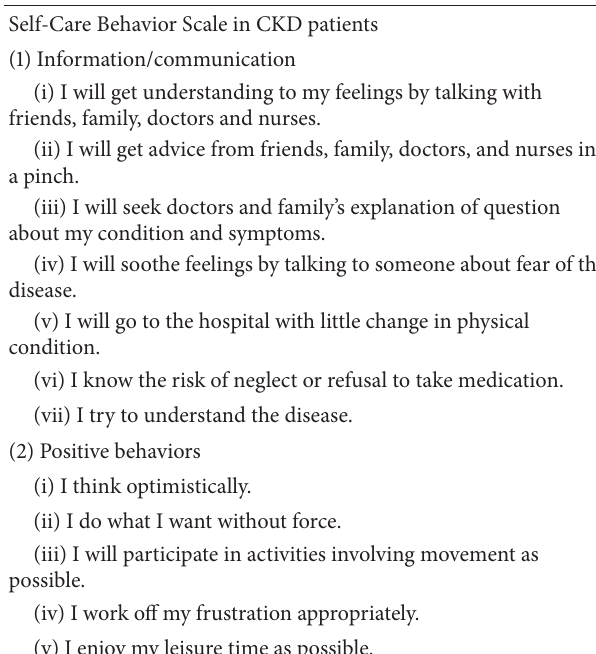
Table 1: A scale to assess the practice of self-care behaviors for chronic kidney disease